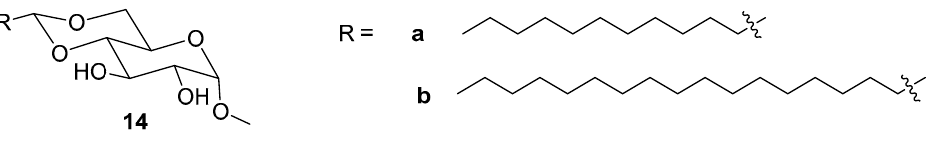
Figure 7. Gelators from methyl alpha-D-glucopyranoside [47].